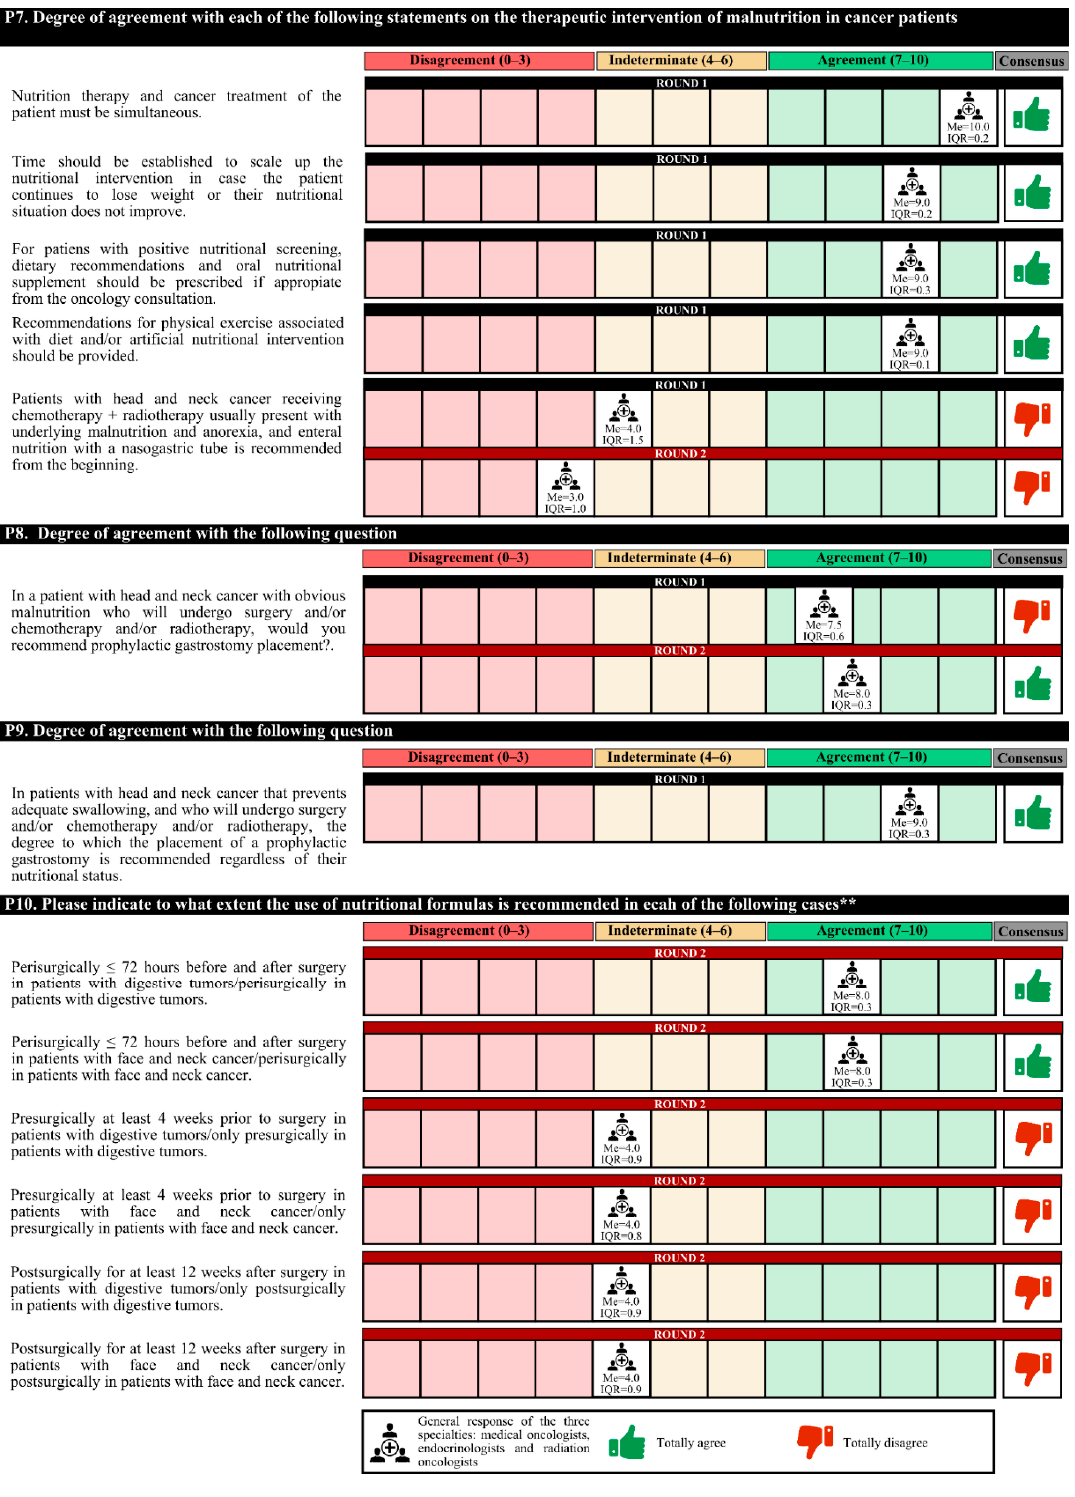
Figure 5. Answers about nutritional therapy (I). ** The rephrased questions for the second round are shown due to a lack of understanding in the first round. IQR, interquartile range; Me, median.